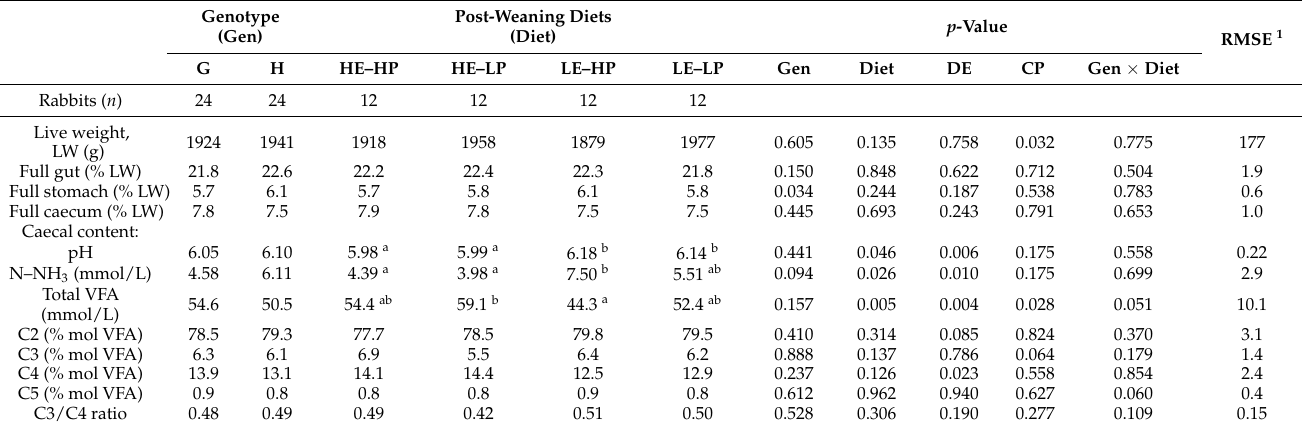
1 Root mean square error. G = Grimaud crossbred rabbits. H = Hyla crossbred rabbits. HE–HP = diet with high digestible energy and high crude protein content (10.9 MJ DE/kg; 159 g CP/kg). HE–LP = diet with